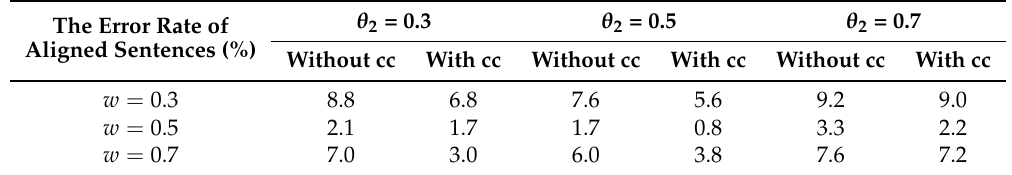
Table 2. Experiment results of the error rate of aligned sentences with the threshold θ 2 and the weight w for 300k training data. “Without cc” indicates without using the common Chinese character information; “With cc” indicates using the common Chinese character